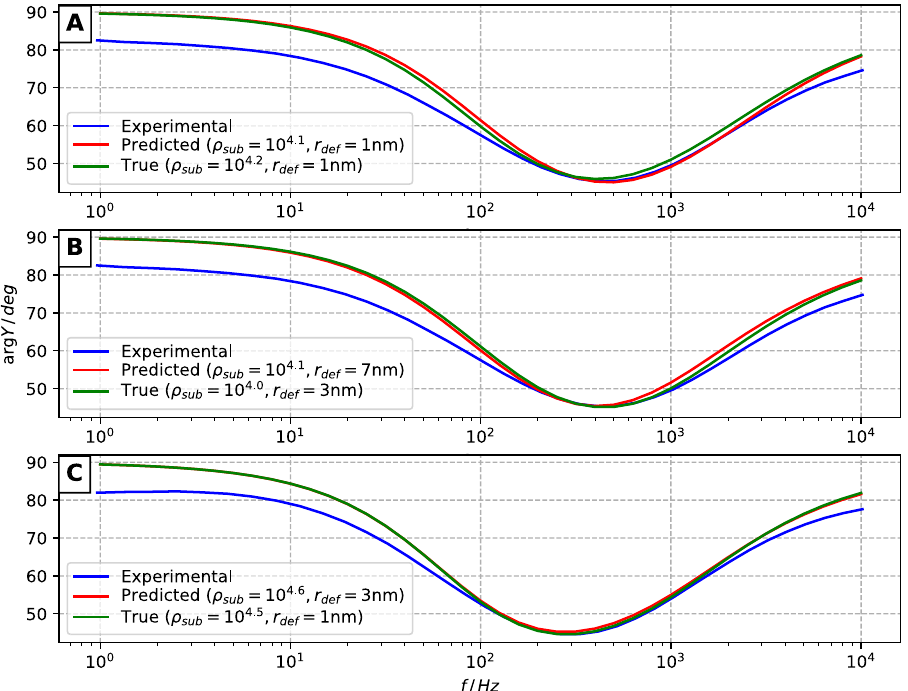
Figure 8. Admittance phase data of experimental EIS measurements (blue curves) versus modeled cases (green and red curves corresponding to manually annotated defect coordinates and CNN model predictions, respectively). (A–C) correspond to AFM surfaces 1, 2 and